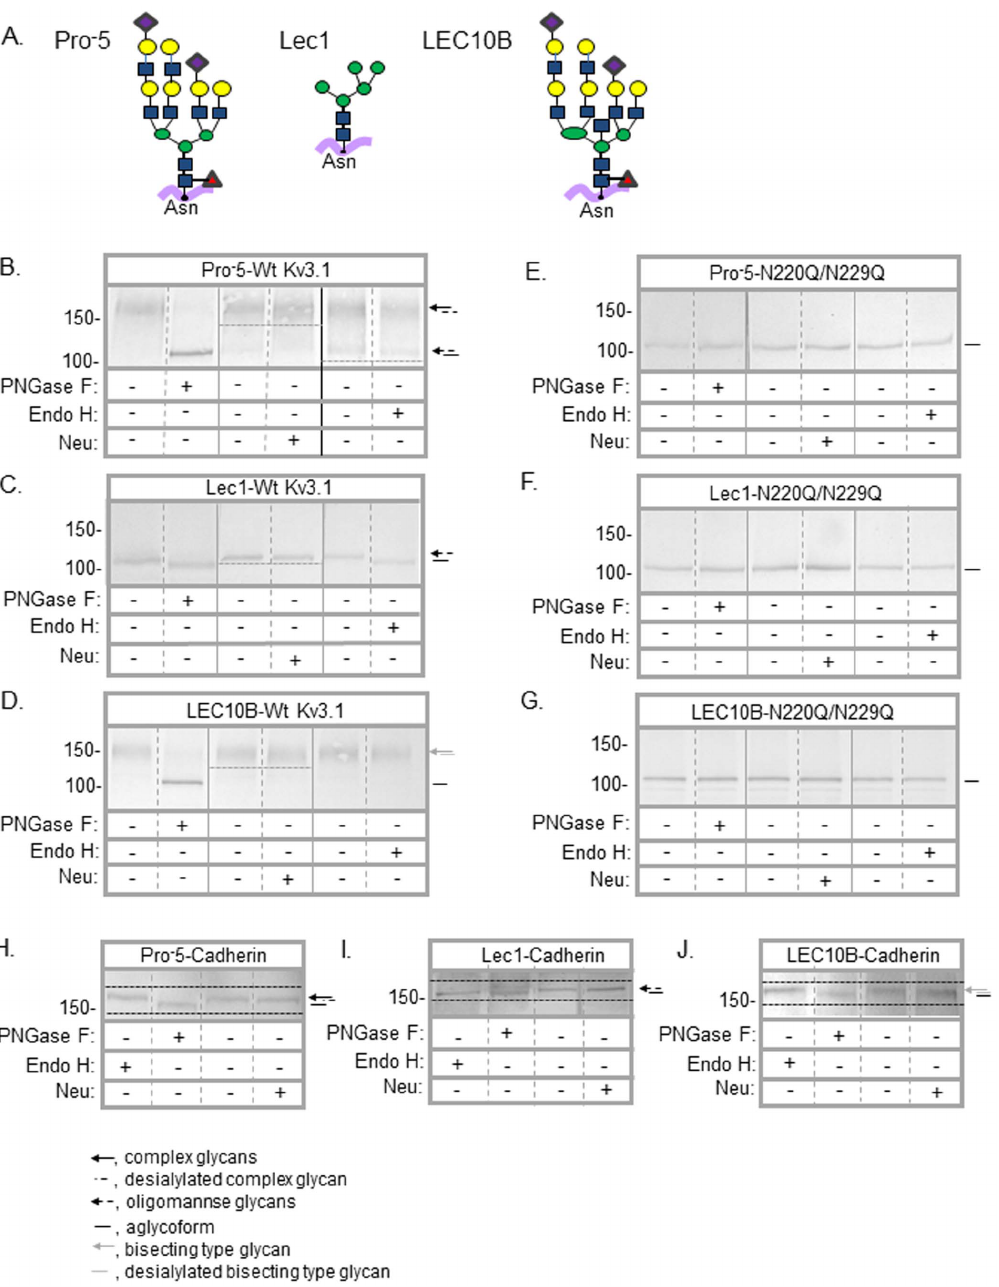
Figure 1. Western blots of Kv3.1 and E-cadherin glycoproteins expressed in various CHO cell lines. Diagram depicting the predominant N N N -linked glycans present in each CHO cell line studied (A). Symbolic nomenclature is presented as outlined by the Consortium for Functional green circle, mannose; yellow circle, galactose; ¤ , sialic acid; m , fucose. Glycomics Nomenclature Committee as follows: & , N -acetylglucosamine; Western blots of wild type (Wt) and N220Q/N229Q Kv3.1 proteins, and E-cadherin glycoprotein digested ( + ) and undigested ( 2 ) with PNGase F, Endo H, and neuraminidase (neu) when heterologously expressed in Pro - 5 (B,E,H), Lec1 (C,F,I), and LEC10B (D,G,J) cells, as indicated. Dashed lines below and/or above the immunobands on the various panels were employed to emphasize the small electrophoretic shifts. Solid black vertical lines denote different blot. The numbers adjacent to the Western blots represent the Kaleidoscope markers (in kDa). doi:10.1371/journal.pone.0075013.g001 Leucoagglutinin (L-PHA), Galanthus Nivalis Lectin (GNL), and bisecting type N -glycans, respectively. Further the majority of Phaseolus vulgaris Erythroagglutinin (E-PHA), respectively [13]. As glycoproteins expressed in both transfected LEC10B cells also expected, lectin blots of total membranes revealed that by far the interacted with L-PHA while they did not interact with GNL, majority of the glycoproteins expressed in either the Kv3.1 indicating that the majority of glycoproteins with bisecting type N - (Figure 2A) or E-cadherin (Figure 2B) transfected Pro-5, Lec1 and glycans were complex N -glycans. In both cases, relative amounts of LEC10B cell lines consisted of complex, oligomannose and